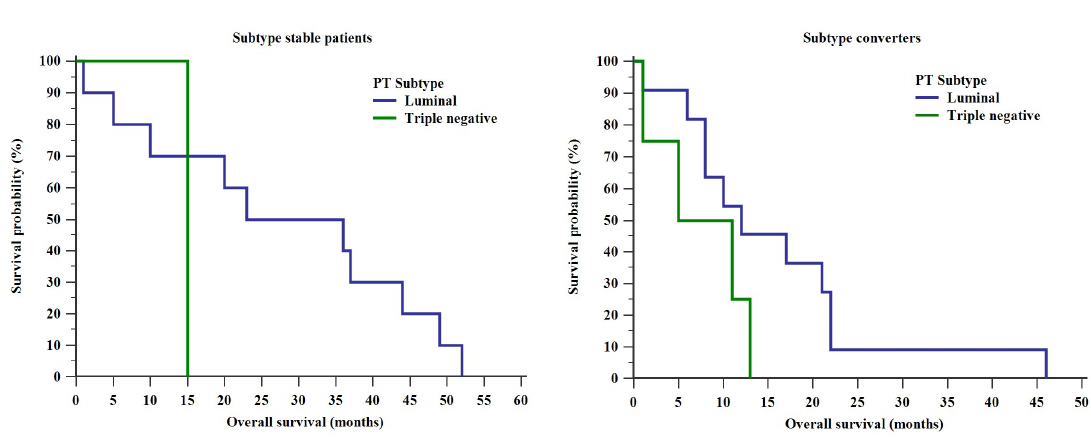
Figure 3. Differences in OS between different PT subtypes in subtype stable patients and in subtype converters .